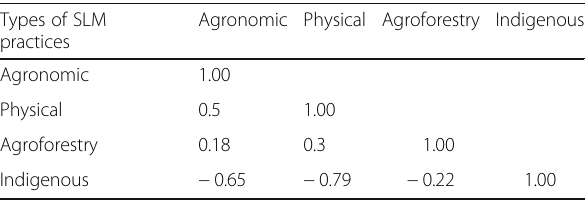
Table 7 Correlation coefficient among the four SLM